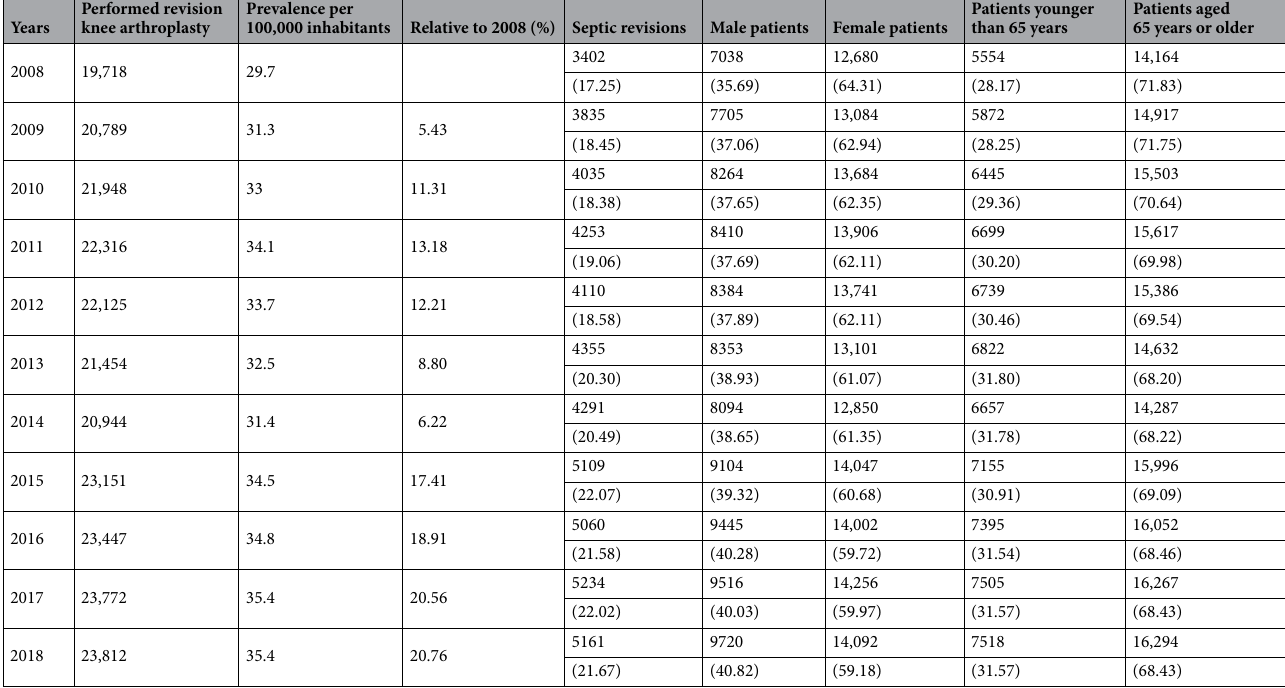
Table 2. Development of revision knee arthroplasty numbers.